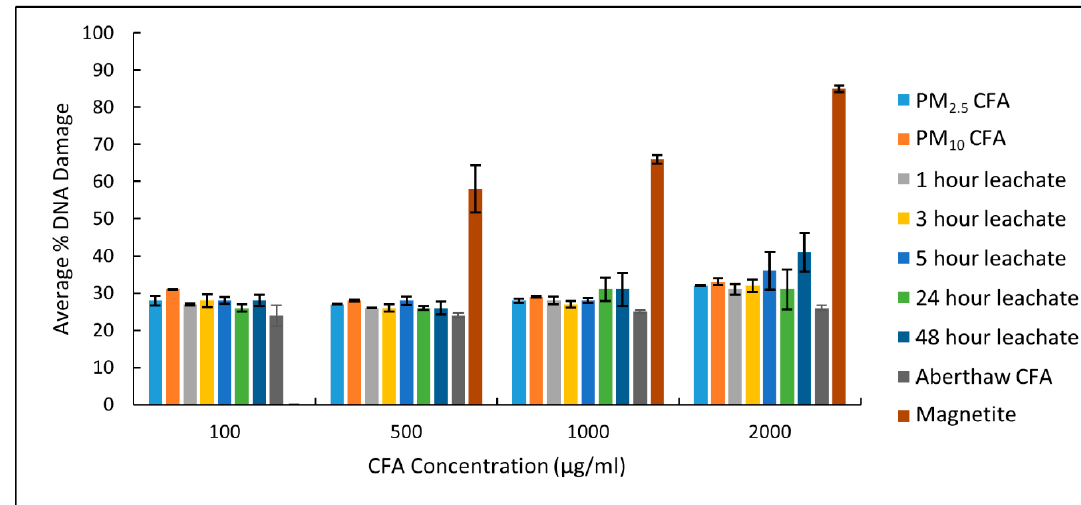
Figure 3. Damage caused to plasmid DNA by CFA suspended in H 2 O and an iron oxide control. The only significant ( p < 0.05) increases in damage came from the 48 h leachate (2000 µg/mL) and the magnetite (500, 1000, and 2000 µg/mL). All results are minus the negative control (H 2 O), and the mean ( n = 4) result is shown. Error bars display standard deviation (SD).